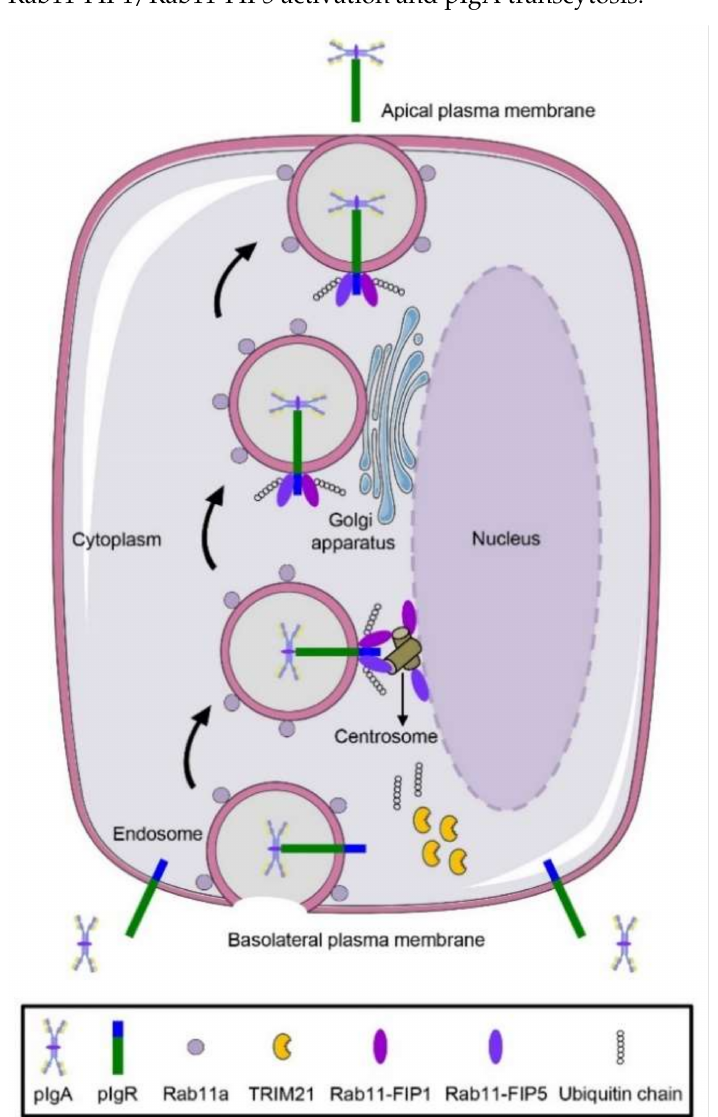
Figure 7. A working model on Rab11-FIP1- and Rab11-FIP5-mediated pIgA transcytosis in incom- pletely polarized cells. In our incompletely polarized cells model, pIgA is recognized and bound by pIgR upon pIgA treatment. Subsequently, the endocytic pIgR–pIgA complex is delivered by Rab11a-positive endosomes. The complex is first transported from the basolateral plasma membrane to the vicinity of the centrosome where Rab11-FIP1 and Rab11-FIP5 bind to it. During the traffick- ing process, TRIM21 mediates the K11-linked polyubiquitination of Rab11-FIP1 and the K6-linked polyubiquitination of Rab11-FIP5 to promote their activation. With the assistance of Rab11-FIP1 and Rab11-FIP5, pIgR–pIgA complex is further transferred to the apical plasma membrane via Golgi apparatus and then